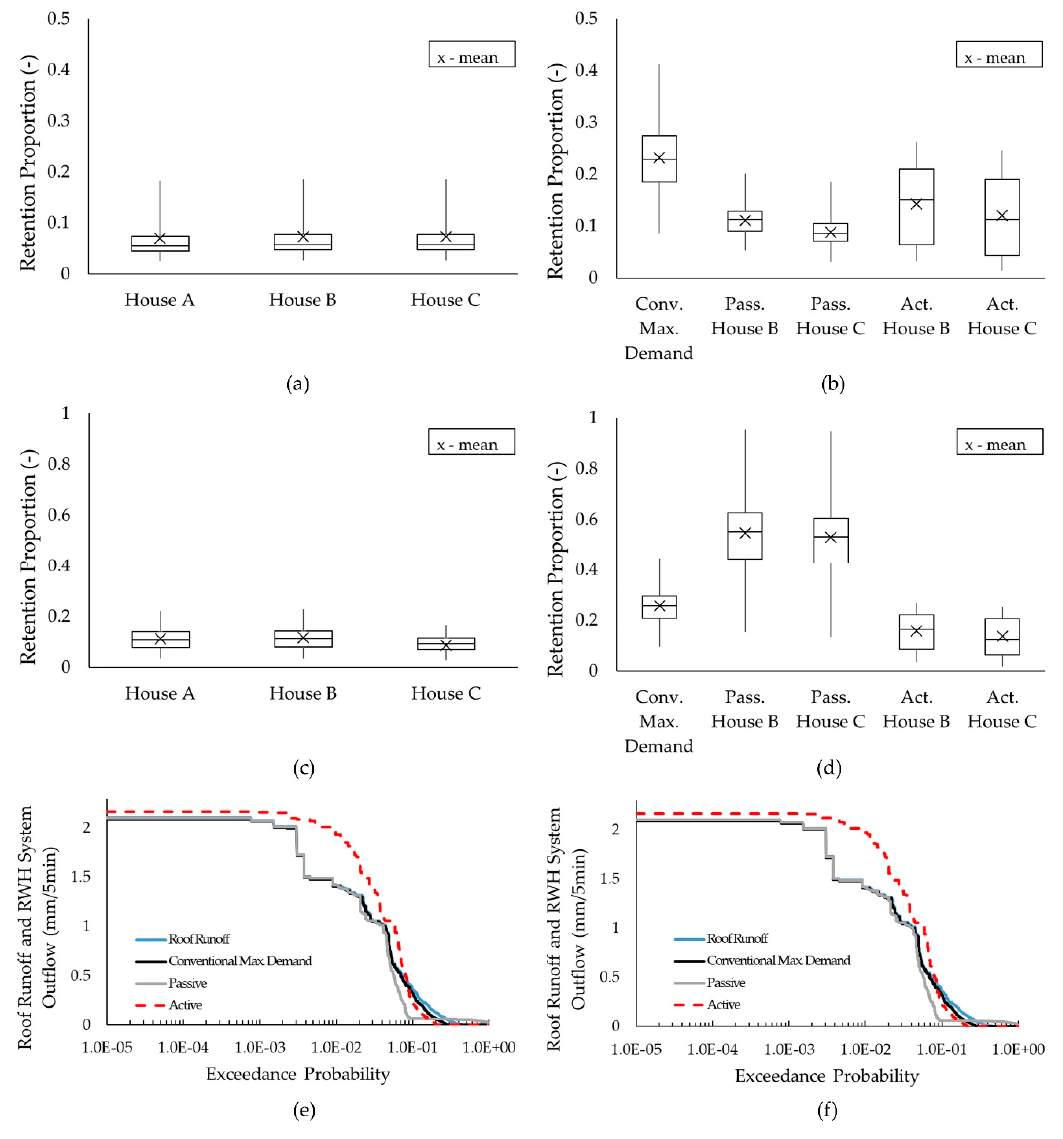
Figure 4. Modelled stormwater management performance during 30 largest events: ( a ) retention—original demand; ( b ) retention—suggested scenarios; ( c ) retention below greenfield runoff—original demand; ( d ) retention below greenfield runoff—suggested scenarios; ( e ) flow duration curve—House B; ( f ) flow duration curve—House C.